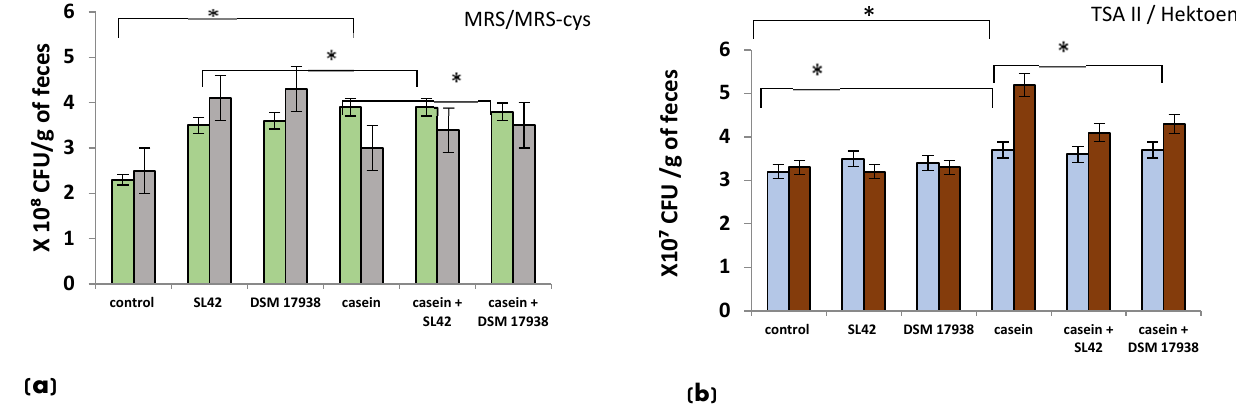
Figure 6. Bacteria numbers as determined by plating technique (n = 8 rats/ group). Lactic acid bacteria ( a ), Clostridia species ( b ). Wistar rats were sensitized intragastrically by administration of casein without adjuvant. The rats were fed every other day with L. rhamnosus SL42 or L. reuteri DSM 17938 at 1 × 10 8 CFU/mL (feces were collected on the 59th day). The dose volume was 1 mL. The control group was fed with sterilized PBS solution. The data (MRS toen ) are presented as the mean ± SD. Statistical analysis was conducted by using one-way ANOVA with Tukey’s multiple comparisons test. * p < 0.05. Control group receiving only PBS (con- trol group); nonsensitized group treated with SL42 strain (SL42 group); nonsensitized group treated with DSM 17938 strain (DSM 17938 group); casein-sensitized group (casein group); casein-sensi- tized group treated with SL42 (casein + SL42 group); and casein-sensitized group treated with DSM 17938 strain (casein- + DSM 17938 group). 3.6. Probiotic Administration Does Not Change Spleen and Thymus Weights Figure 7 shows the effects of the two probiotic strains SL42 and DSM 17938 on the thymus and spleen indices of the rats. Compared with the control group, the thymus and spleen indices were not found to be significantly different in the SL42 and DSM 17938 probiotic-treated groups (all p > 0.05). Figure 7. Effects of probiotic bacteria on the thymus and spleen indices of rats. Wistar rats were sensi- tized intragastrically by administration of casein without adjuvant. The rats were fed every other day with L. rhamnosus SL42 or L. reuteri DSM 17938 at 1 × 10 8 CFU/mL. The dose volume was 1 mL. The control group was fed with sterilized PBS solution. Thymus and spleen samples from each group were collected on the 59th day (day of sacrifice). The thymus and spleen indices were measured as the ratio of the thymus or spleen weight to rat body weight. Values are means ± SD (n = 8 rats/group). No significant differences were observed at p > 0.05. Control group receiving only PBS (control); nonsen- sitized group treated with SL42 strain (SL42); nonsensitized group treated with DSM 17938 strain (DSM 17938); casein-sensitized group (casein); casein-sensitized group treated with SL42 (casein + SL42); and casein-sensitized group treated with DSM 17938 strain (casein- + DSM 17938).